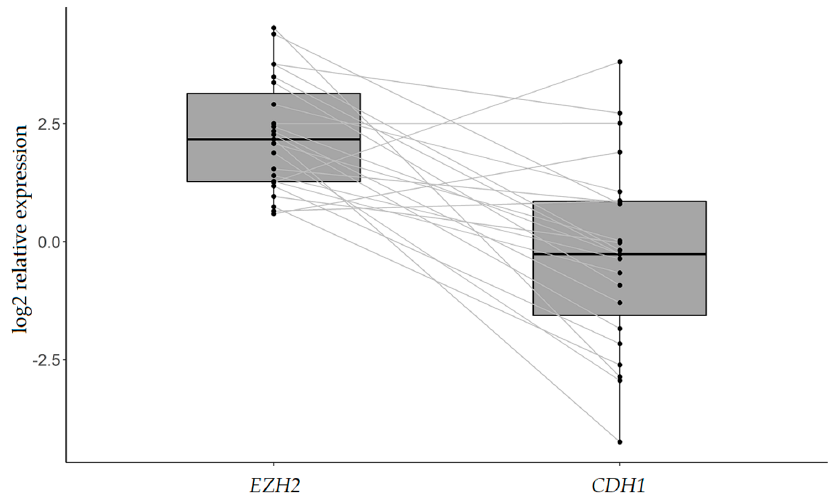
Figure 5. EZH2 upregulation and its association with CDH1 expression. Box plots of CDH1 expression in relation to EZH2 expression in 23 IGC patients with EZH2 upregulation. Relative expression is measured as log2 FC. p -value < 0.001 (Mann − Whitney test).